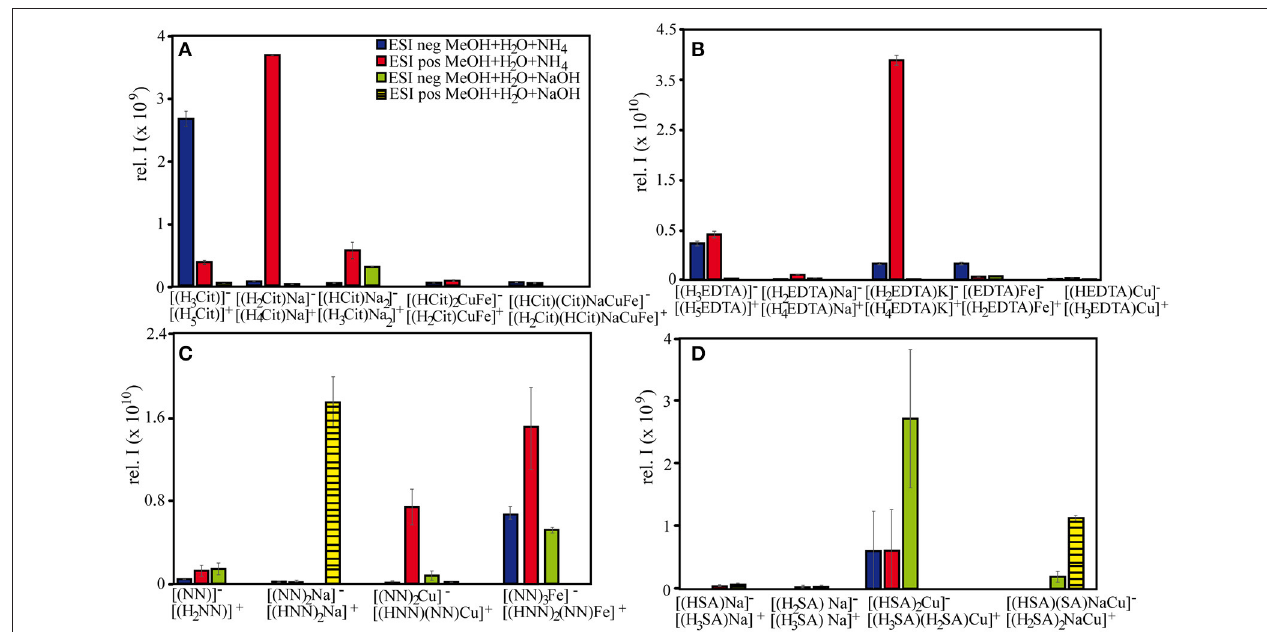
FIGURE 4 | Signal intensities of selected (A) citrate, (B) EDTA, (C) NN, and (D) SA species under different measurement settings. All depicted samples were prepared with a methanol:water matrix, with differing bases and ionization